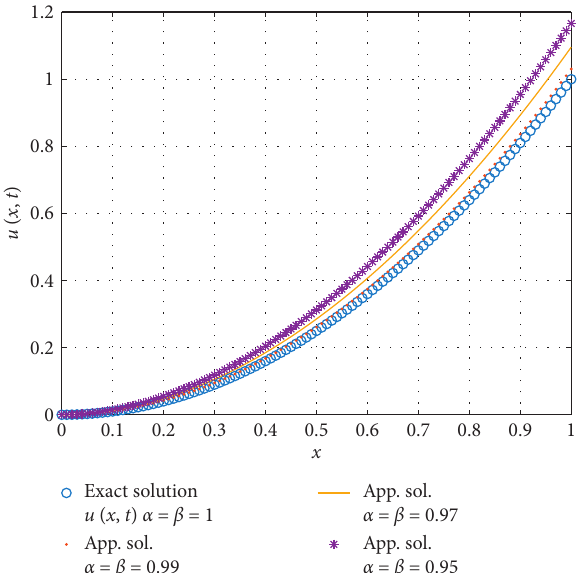
Figure 1: The exact and approximate solutions of u ( x,t ) for Example 3, when α � β .